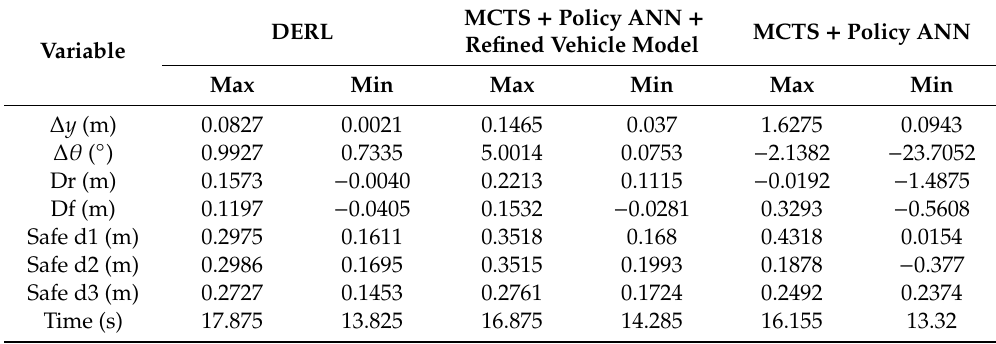
Table A2. Test extreme results for training poses for 25 × 3 parking trials.